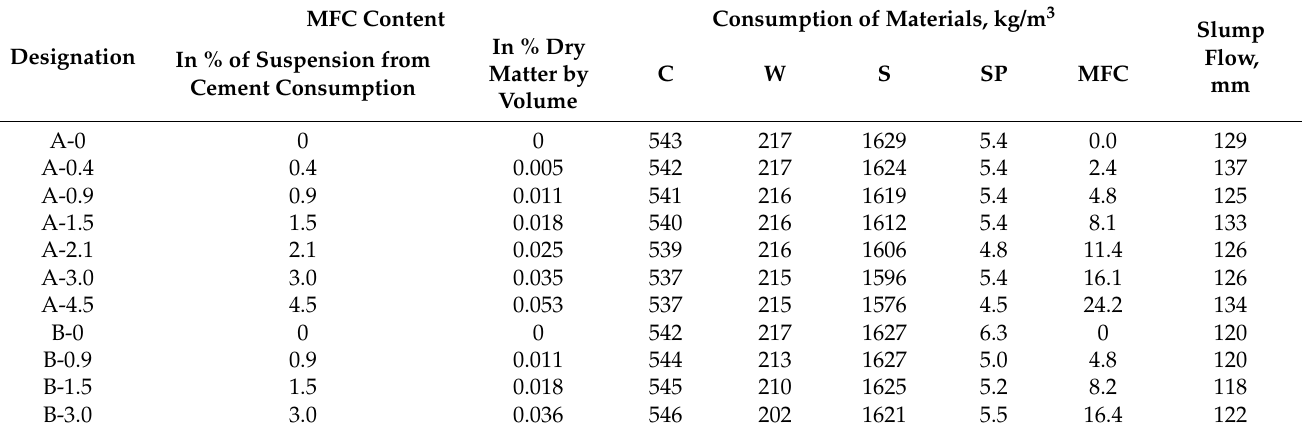
Table 1. Consumption of materials for the investigated compositions.